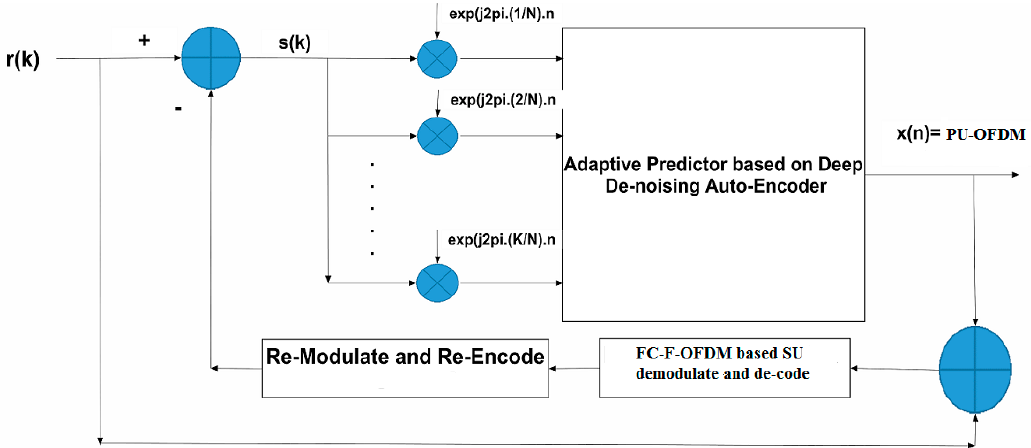
Figure 2. Cyclic FRESH filtering using Deep De-noising Auto-Encoder (DDA) in NOMCR signal demodulation. The DDA based FRESH filtering steps are tabulated below (Algorithm